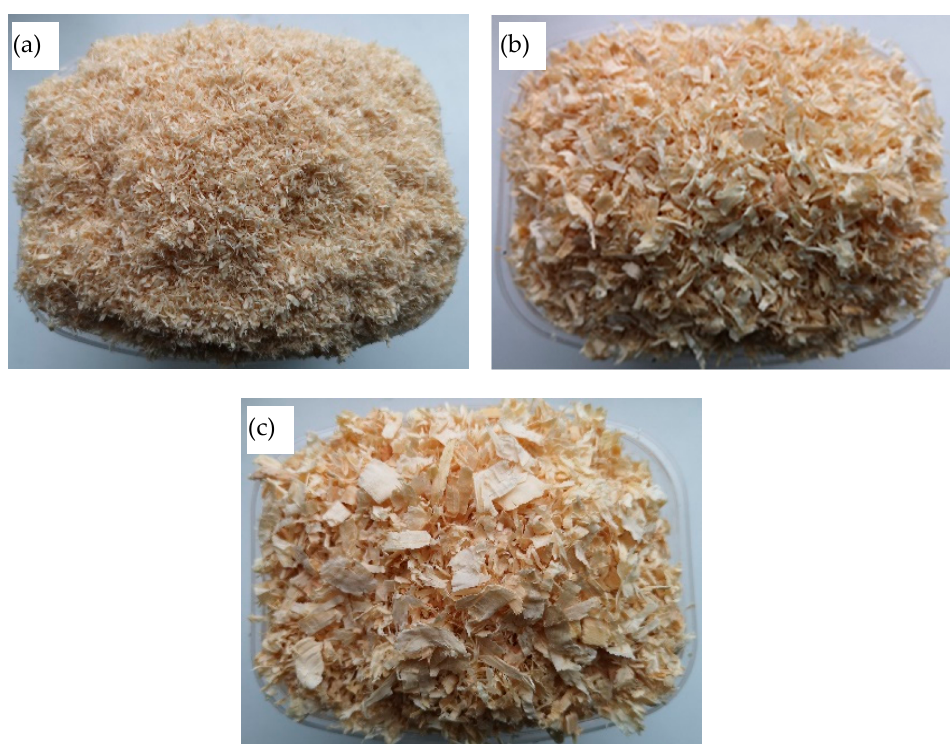
Figure 1. Image of the wood waste particles after being crushed using different sieve sizes, mm: ( a ) 5; ( b ) 10; ( c ) 20.